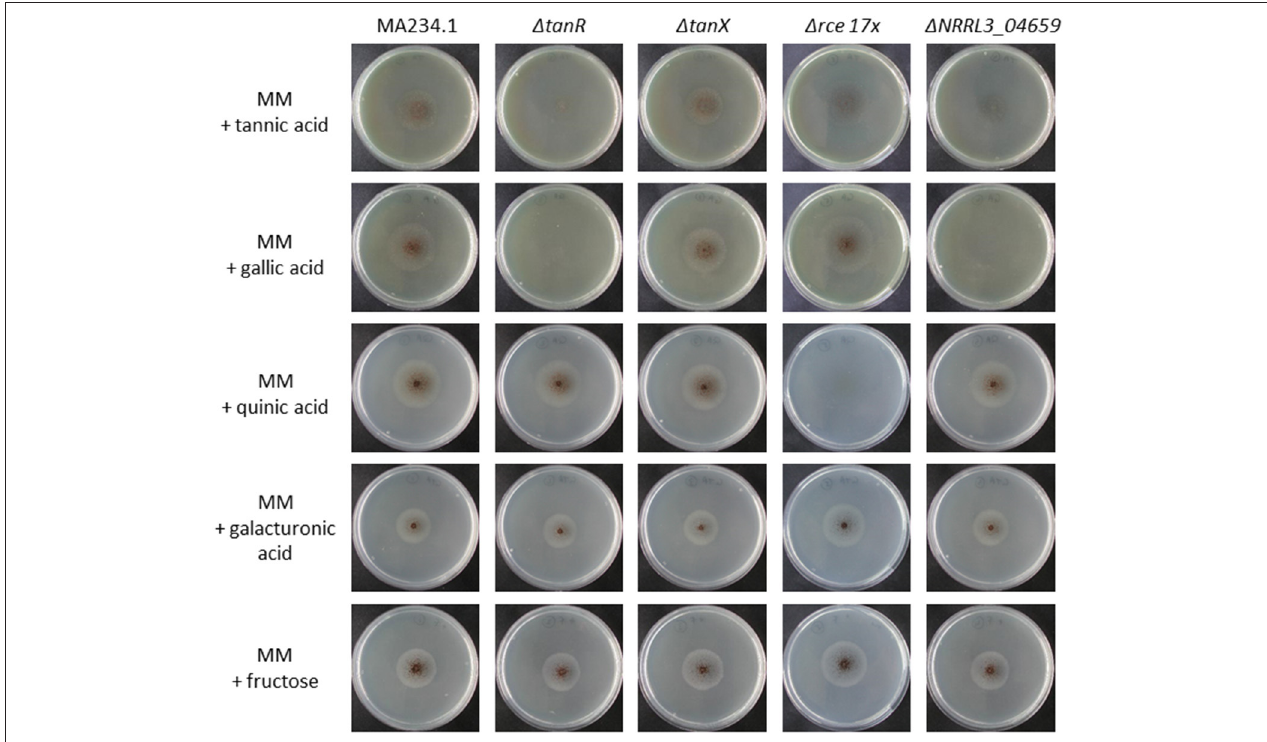
FIGURE 3 | Growth analysis of A. niger reference strain (MA234.1), 1 tanR, 1 tanX, 1 rce 17x , and 1 gacA ( 1 NRRL3_04659) on various carbon sources. Spores were point inoculated on minimal medium (MM) supplemented with the indicated carbon source (5mM). Strains were grown for 5 days at 30 ◦ C before pictures were taken.